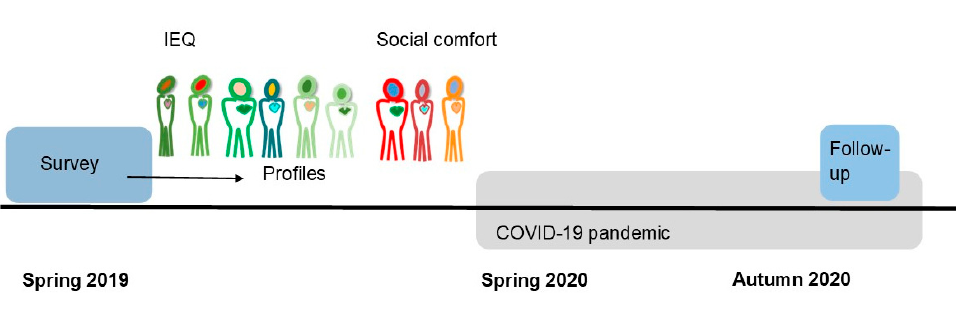
Figure 1. Timeline profiles.